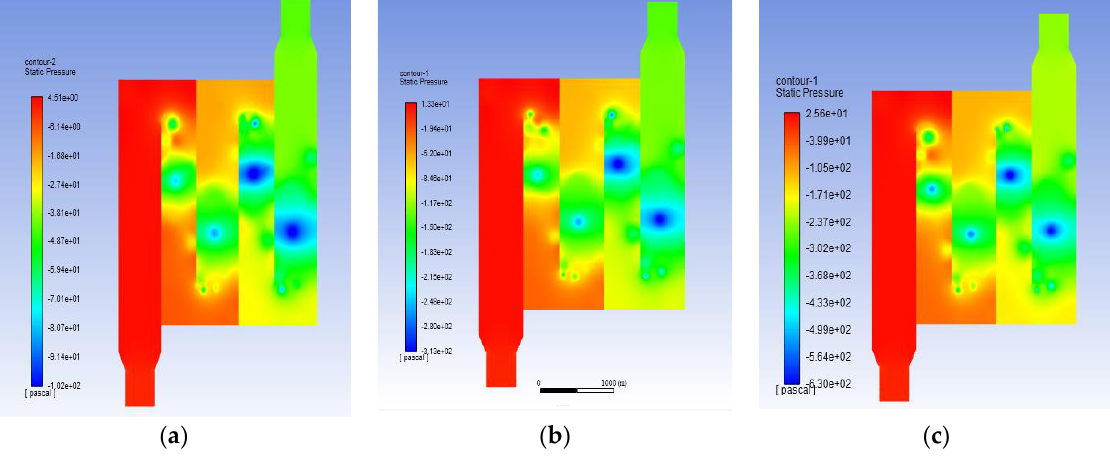
Figure 5. The pressure distributions corresponding to different inlet flue gas velocities. ( a ). Pressure nephogram for v fg = 3 m · s − 1 . ( b ). Pressure nephogram for v fg = 5 m · s − 1 . ( c ). Pressure nephogram for v fg = 7 m · s − 1